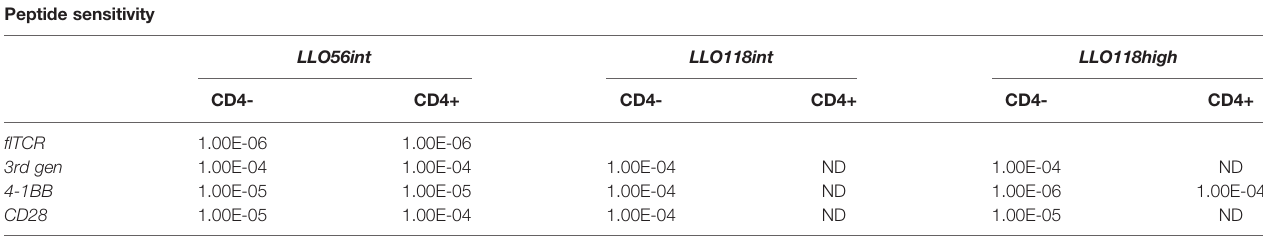
CD4 expression inhibited the production of IL-2 for most clones (marked in light red).